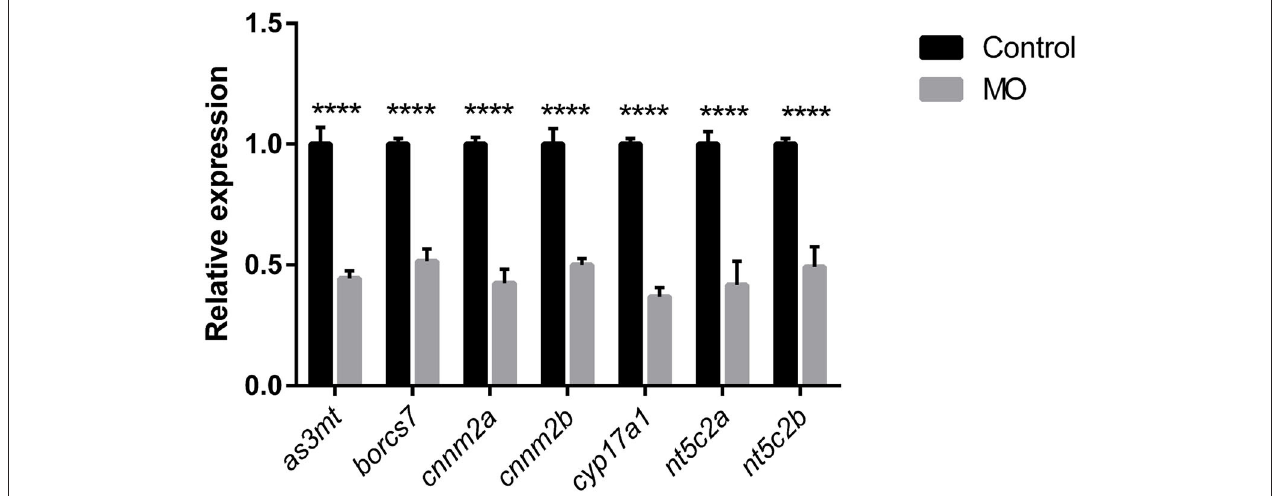
FIGURE 3 | Graph represents downregulation of the relative gene expression of as3mt, borcs7, cnnm2a, cnnm2b, cyp17a1, nt5c2a, and nt5c2b measured at 72h post morpholino injections compare to their respective controls injected with control morpholinos from n = 10 larvae per group. Error bars represents standard deviation and significance was set at p < 0.05. **** represent the significant differences among the samples.